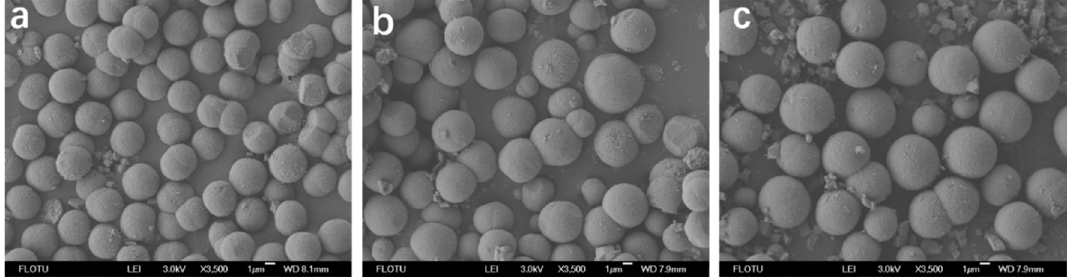
Figure 9. SEM images of products when using starting materials at different ratio ( R M ). ( a ) Ni:Co:Mn = 1:1:1; ( b ) Ni:Co:Mn = 4:2:4; ( c ) Ni:Co:Mn = 5:2:3. C M = 15 mol · L − 1 ; C (NH4)2CO3 = 0.15 mol · L − 1 ; T h = 180 ◦ C; and t h = 24 h. Table 1. Element compositions of products when using starting materials at different ratios.